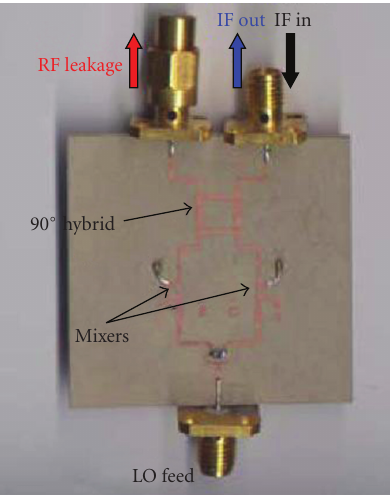
Figure 4: Phase conjugating mixer using 90 ◦ hybrid